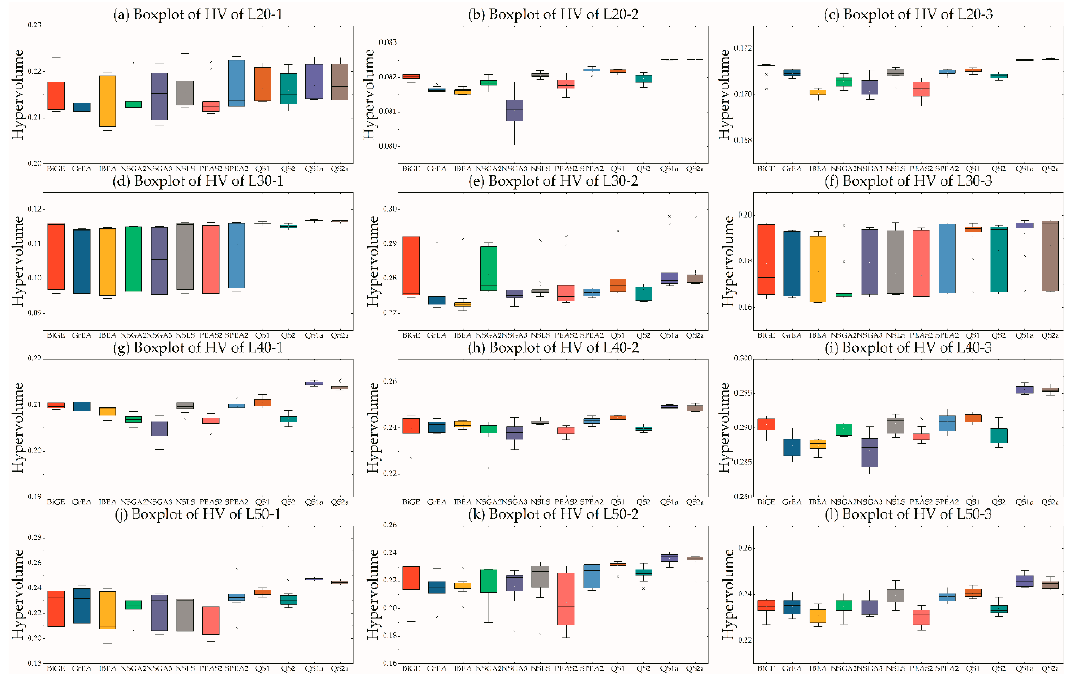
Figure 1. Boxplot of hypervolume of 12 MOEAs.